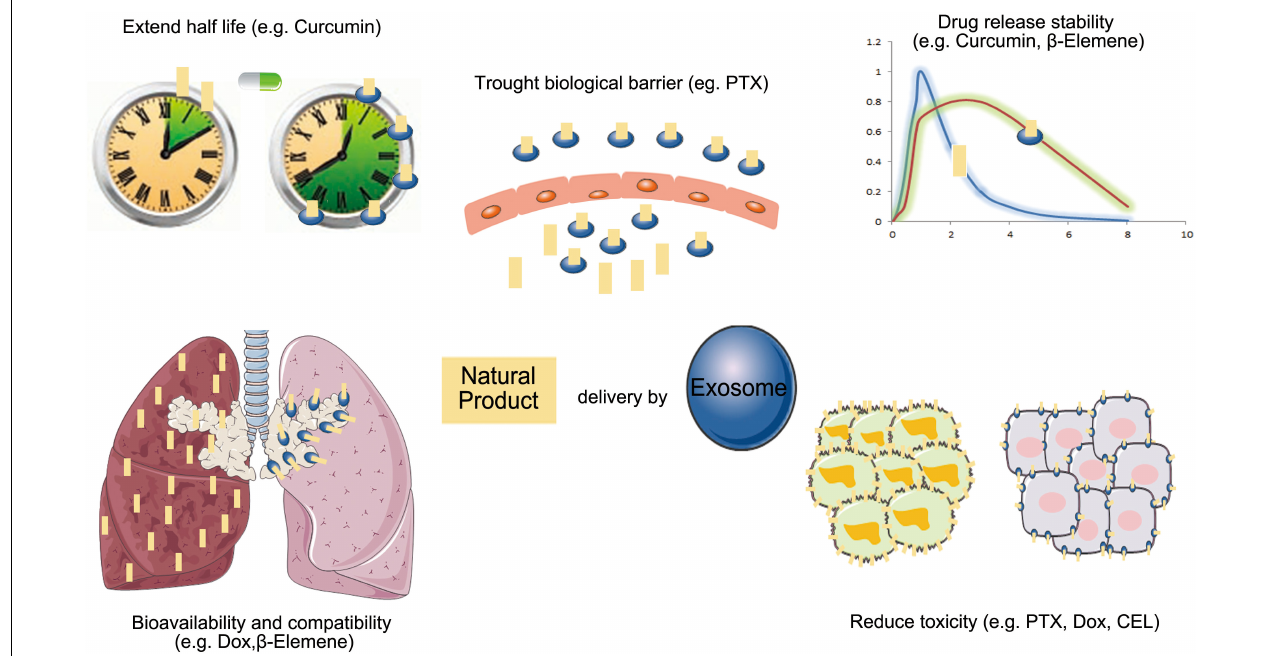
FIGURE 3 | The advantage of exosomes carrier natural products in anti-cancer therapy (PTX, paclitaxel; Dox, doxorubicin; CEL, celastrol).